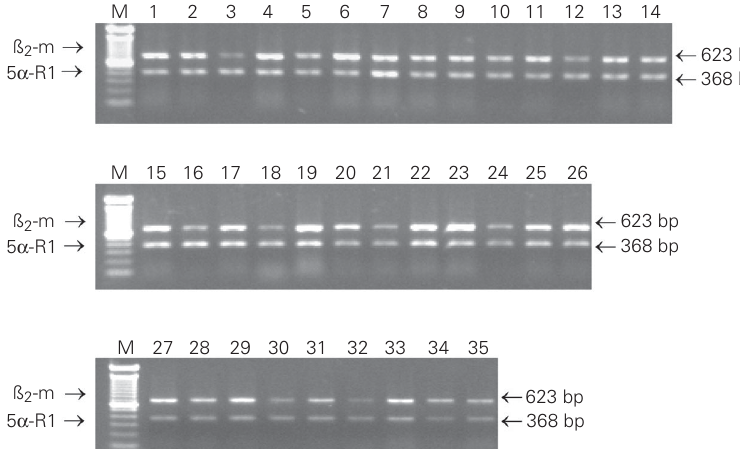
Figure 3. Representative gel showing SDR5A1 mRNA levels determined by RT-PCR in hair cells plucked from the scalp of normal women (1 to 14) and of both groups of hirsute patients (PCOS: 15 to 26; IH: 27 to 35). The 368-bp fragment corresponds to SDR5A1 (5 α - R1), and the 623-bp fragment corresponds to ß 2 -microglobulin (ß 2 -m). RT-PCR products were visualized on agarose gel stained with ethidium bromide.